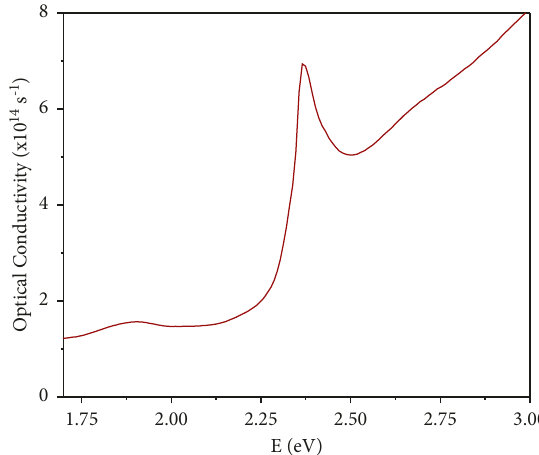
Figure 8: Optical conductivity of the prepared MAPB thin film.